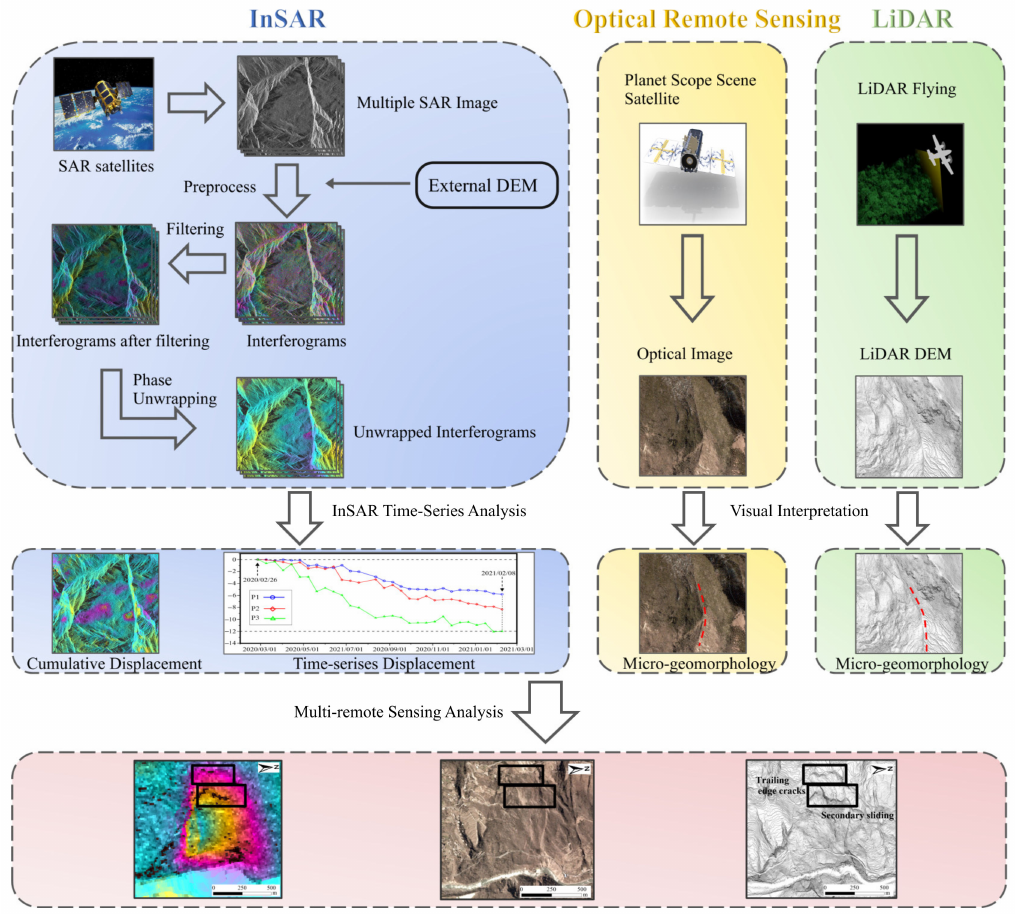
Figure 2. The technical flowchart of the integrated multi-remote sensing technologies approach. The Stacking-InSAR method was used to perform the time series InSAR